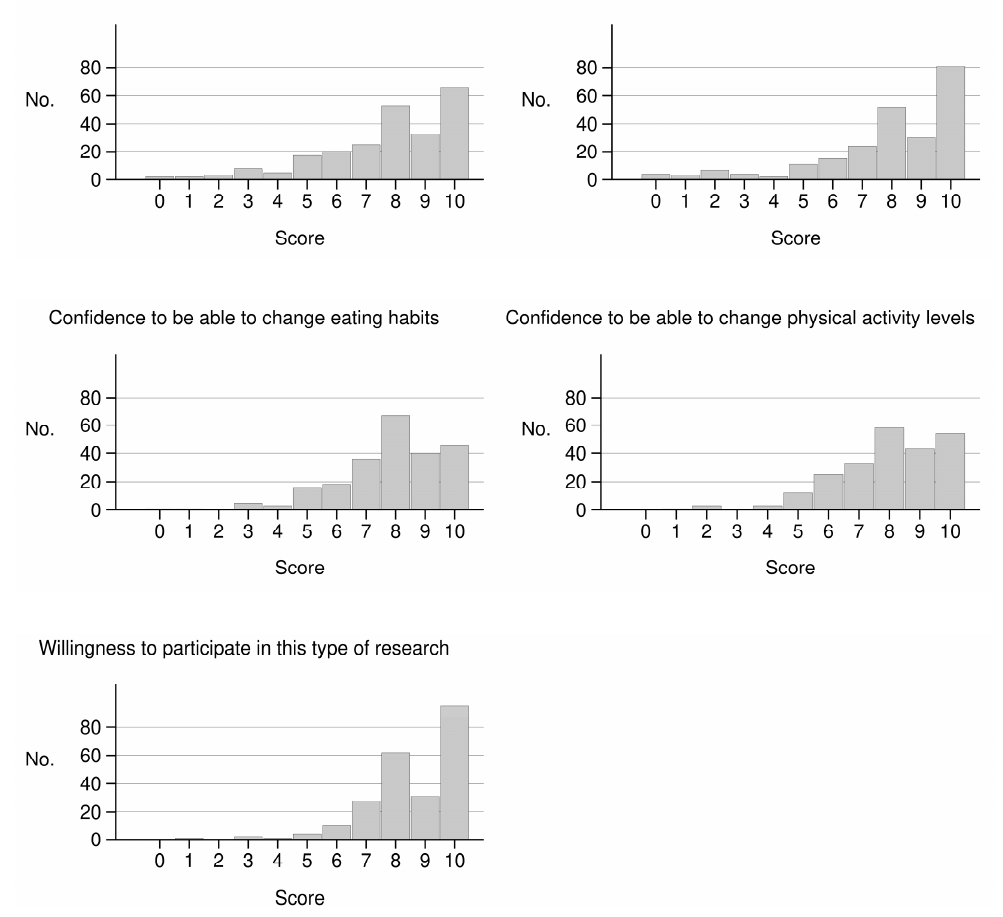
Figure 1. Distribution of responses to the baseline motivation questionnaire in the diet, physical activity and mammography (DAMA) trial. Florence, Italy, 2009–2012.